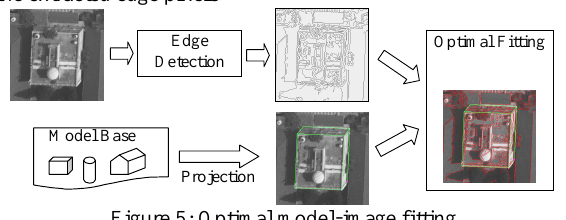
Figure 5: Optimal model-image fitting